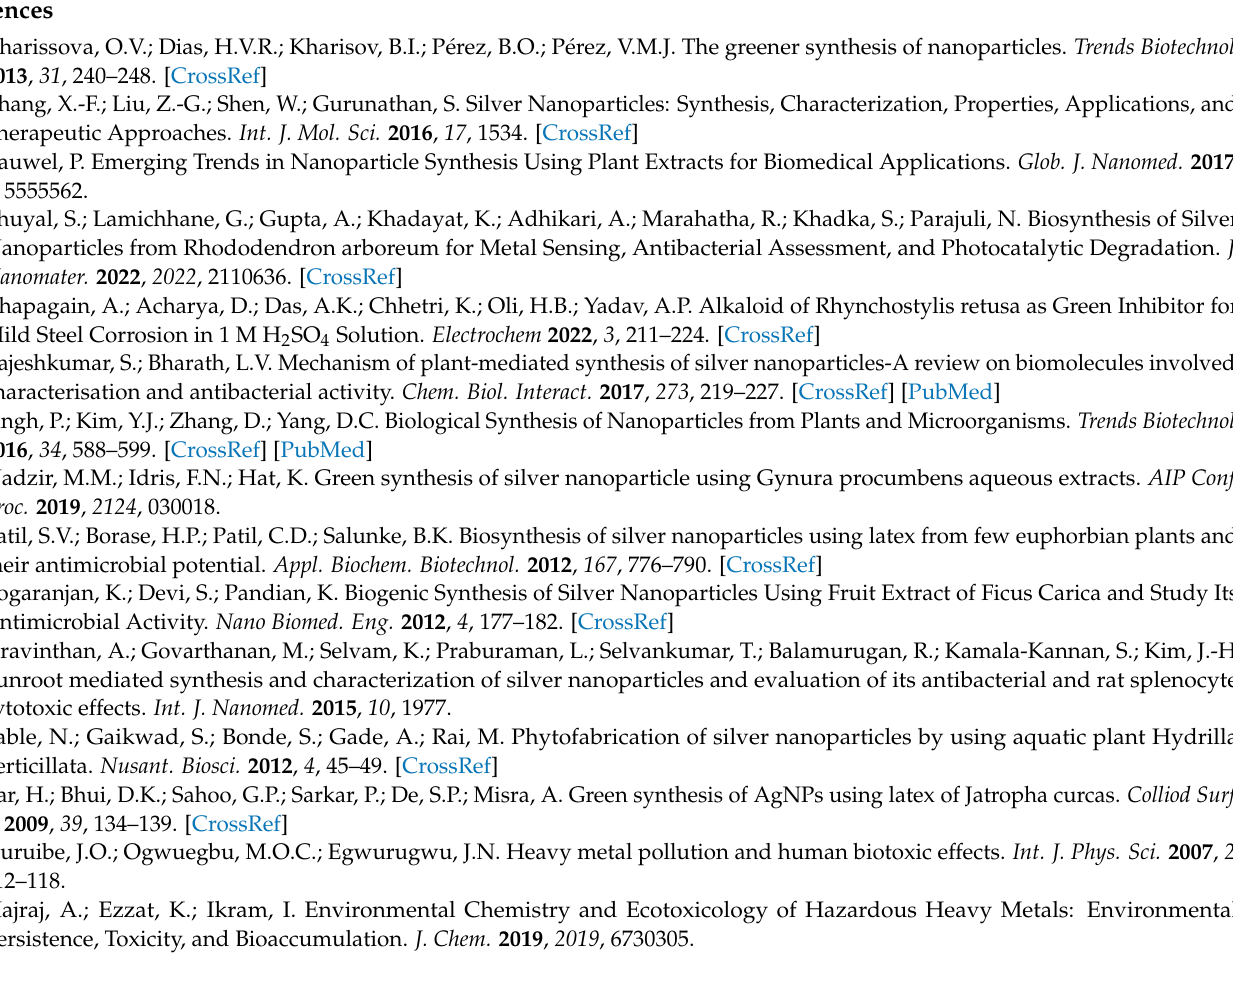
AgNPs, preparation of metal salt solution, colorimetric metal sensing, and catalytic activity of the AgNPs) Figure S1: Color change during the synthesis of AgNPs nanoparticles; Figure S2: Color change on adding (a) 20–200 µ L of Hg 2+ and (b) 300–400 µ L of Hg 2+ ; Figure S3: Photographic image of Artemisia vulgaris